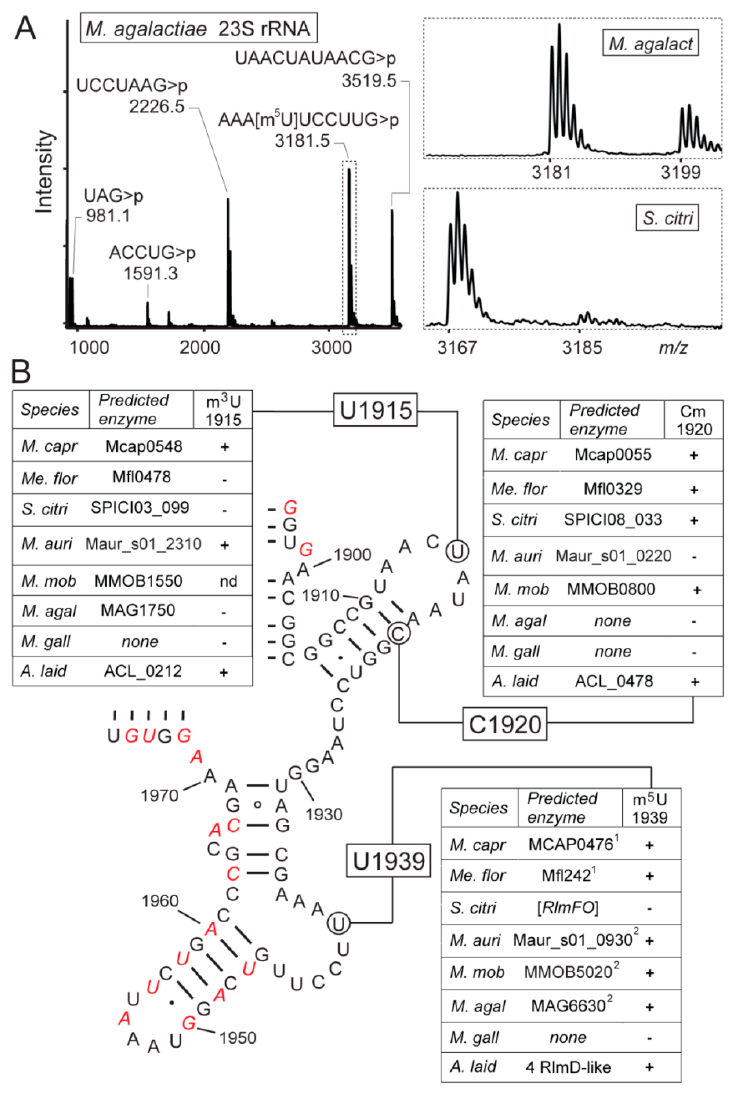
Figure 4. ( A ) MALDI-MS spectrum of RNase T1 fragments from the M. agalactiae 23S rRNA region around nucleotide U1939. The fragment sequences are shown above the peaks with their protonated masses ( m/z ); the m/z measurements are for fragments with a cyclic 3´-phosphate (>p), and are within